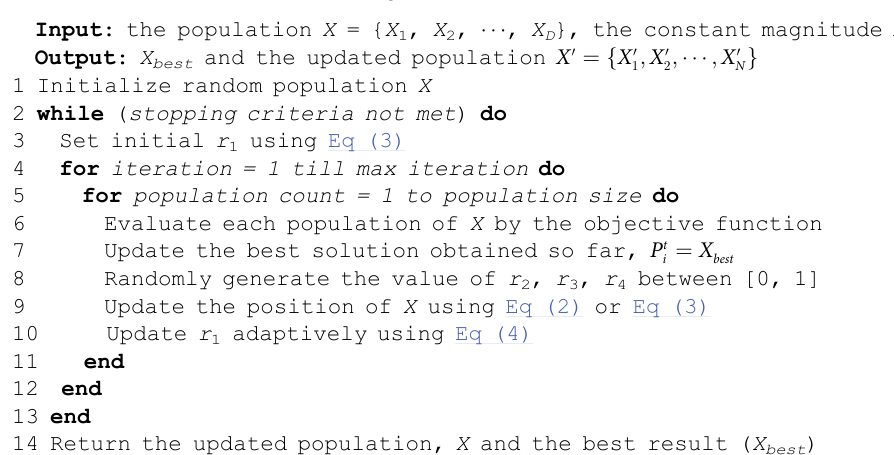
Algorithm 1 : Pseudo Code for SCA Algorithm